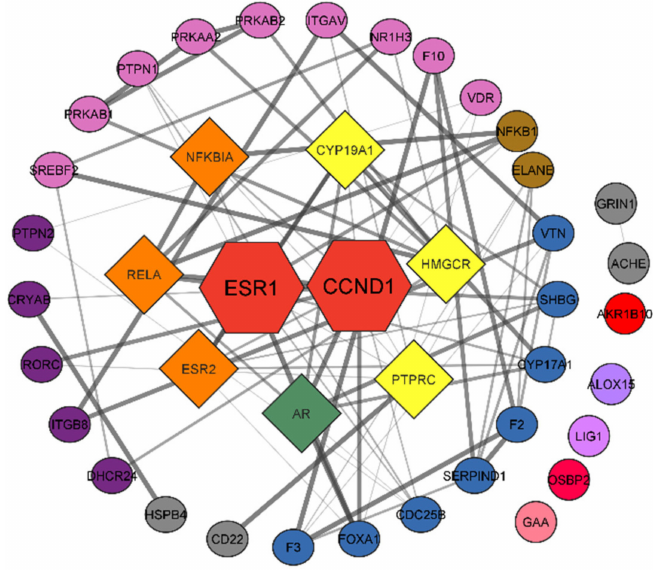
Figure 2. Protein interaction network of glutinol. Table 3. Major protein interaction network topological